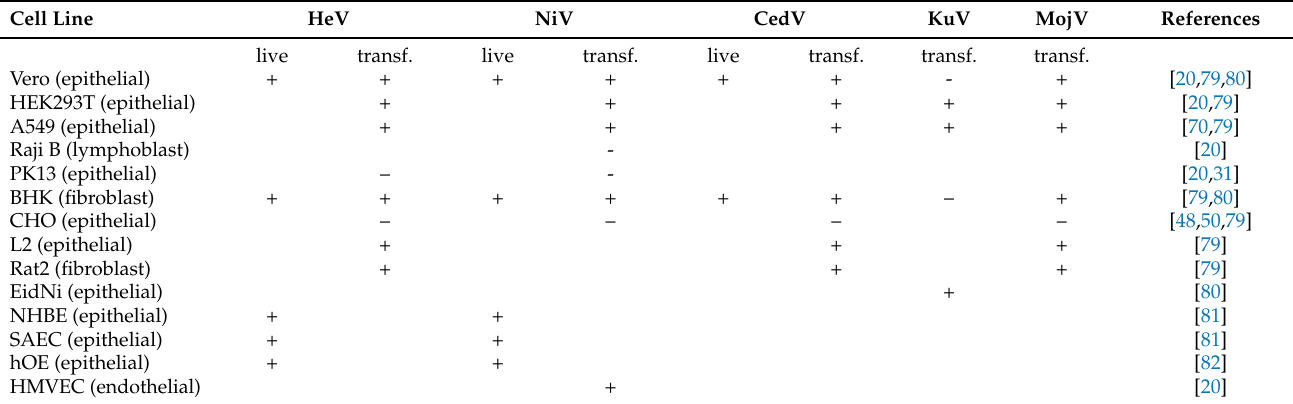
Vero: monkey renal epithelial cells; HEK293T: human renal epithelial cells; A549: human pulmonary epithelial cells; Raji B: human lymphoblast cells; PK13: porcine renal epithelial cells; BHK: baby hamster fibroblasts; CHO: Chinese hamster ovary epithelial cells; L2: rat pulmonary epithelial cells; Rat2: rat fibroblast; EidNi: Eidolon bat renal epithelial cells; NHBE: human bronchi epithelial cells; SAEC: human small airway epithelial cells; hOE: human olfactory epithelial cells; HMVEC: human microvascular endothelial